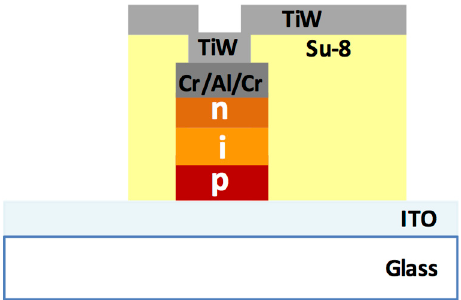
Figure 2. Cross section of the a-Si:H photosensor. Light is impinging through the glass substrate and the ITO (Indium Tin Oxide) bottom transparent electrode, before being absorbed by the p-i-n structure. The following steps are performed on the glass stack containing the microfluidic network: